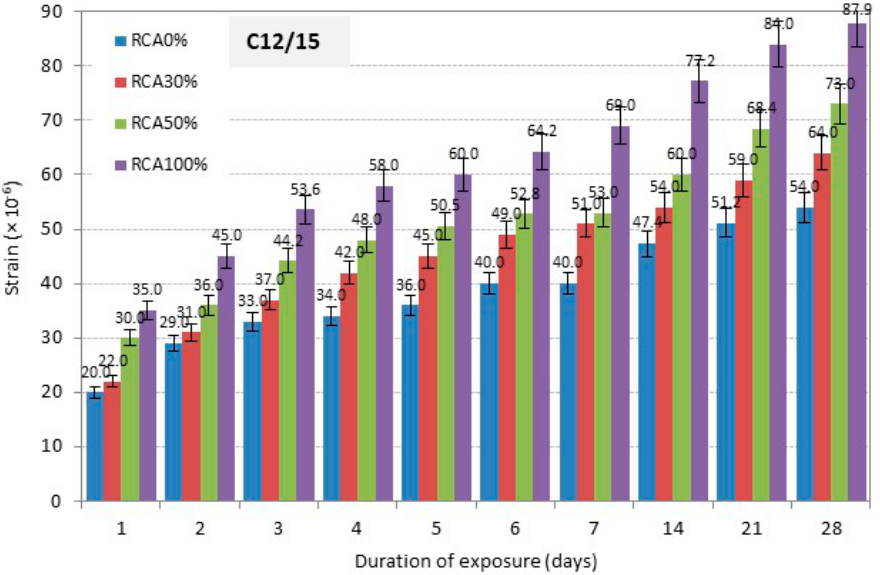
ff ect of RCA content on the expansion due to sulphate attack for the C12 / 15 concretes. Buildings 2020 , 10 , x FOR PEER REVIEW Figure 17. Effect of RCA content on the expansion due to sulphate attack for the C12/15 concretes. Figure 17. E